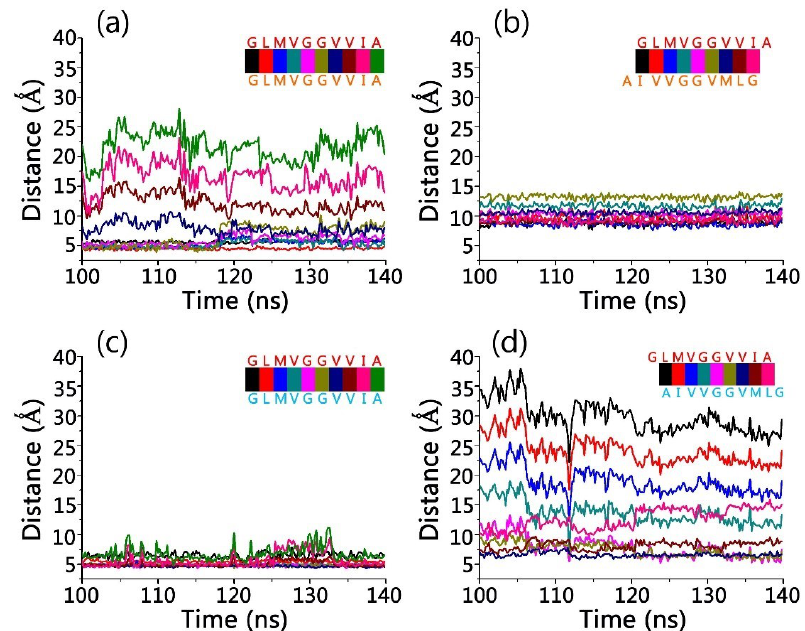
Figure 6. Several key residues contribute to the stable gammabody-A β amyloid interactions. Interfacial residue-residue distance profiles for ( a ) 2U_Backbone; ( b ) 2U_SideChain; ( c ) 3S_Backbone; and ( d ) 3S_SideChain gammabody-A β complexes.